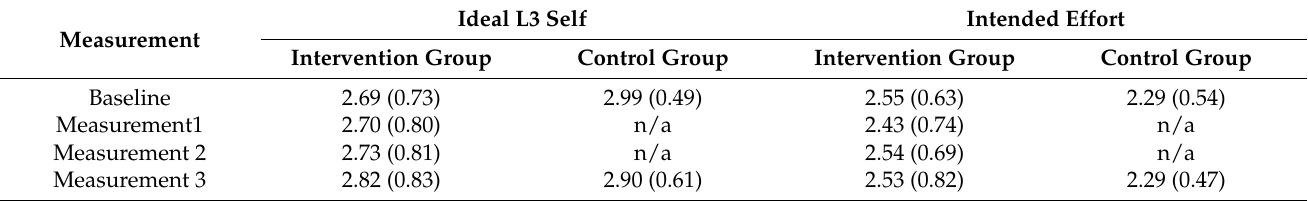
Table 4. Mean and SD for ideal L3 self and intended effort in the two